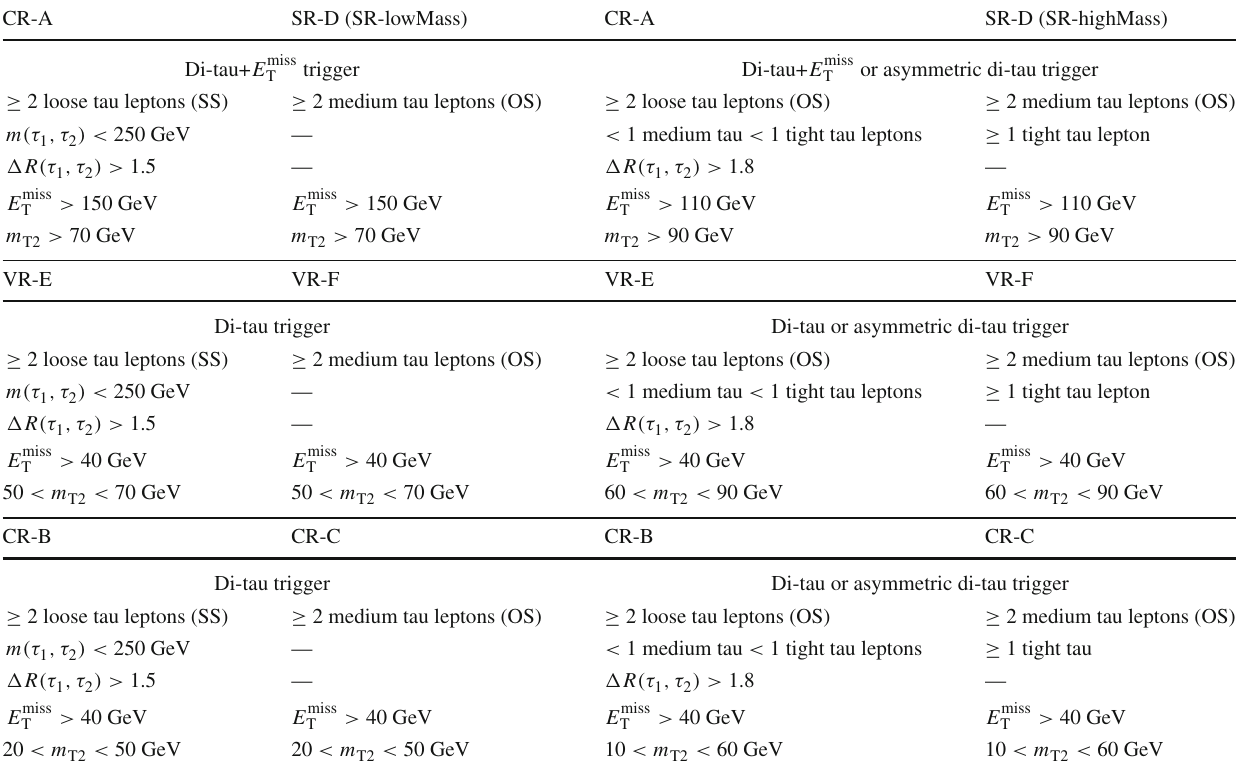
more, two sets of validation regions (VR), VR-E and VR-F, are defined corresponding to each SR. The validation regions are used to verify the extrapolation of the ABCD estimation Table 2 Definition of the regions used in the ABCD method for the multi-jet estimation in SR-lowMass (left) and SR-highMass (right). Only those requirements that are different in the CRs/VRs with respect to the SRs are listed CR-A SR-D